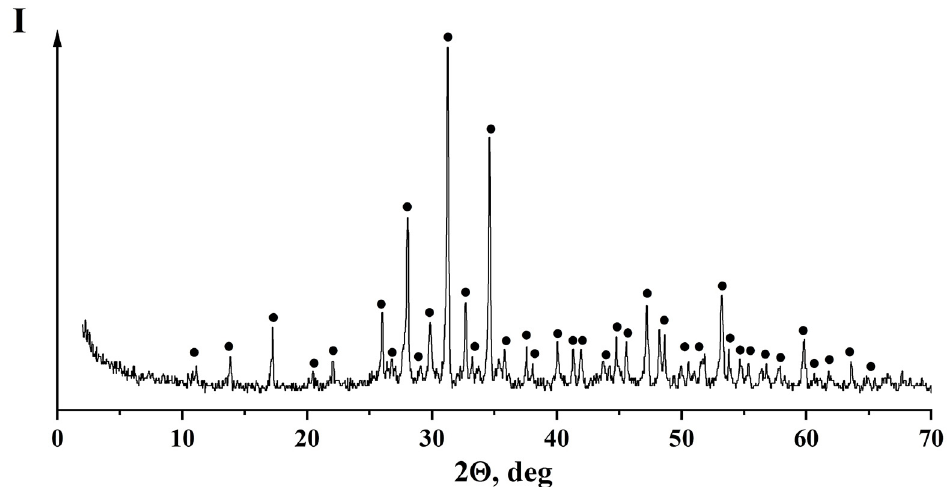
Figure 3. The X-ray diffraction pattern of the preceramic samples based on pastes included tricalcium phosphate Ca 3 (PO 4 ) 2 and the aqueous solution of sodium silicate (Na 2 O · 2,87SiO 2 ) aq : •— Ca 3 (PO 4 ) 2 (PDF card 9–169).